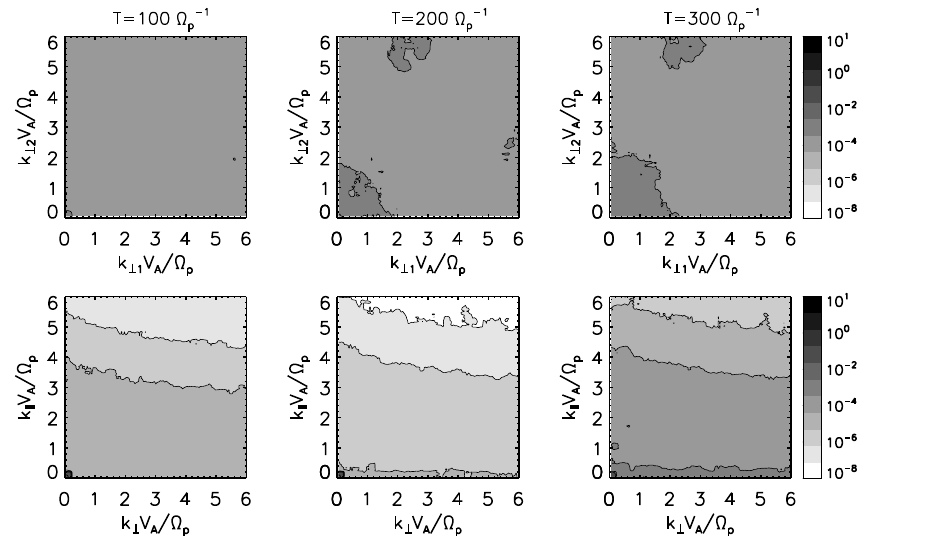
Figure 2. Wavenumber spectrum of the magnetic field fluctuations for the 3-D plasma simulation during the time evolution into turbulence.